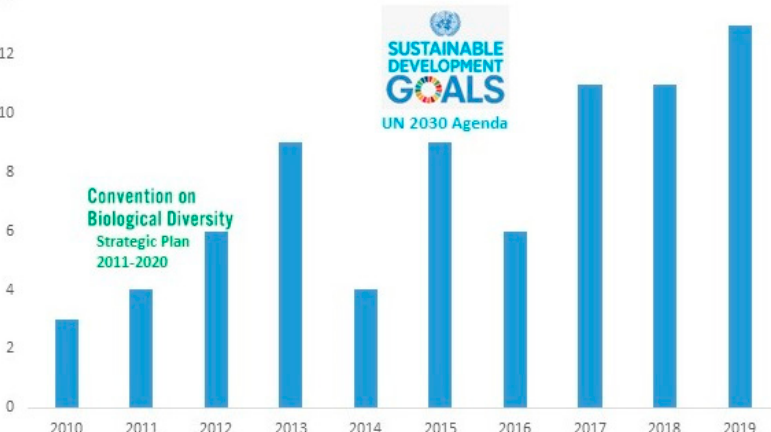
Figure 2. Number of scientific articles on protected areas’ ecological effectiveness published between 2010 and 2019 resulting from a systematic literature review using